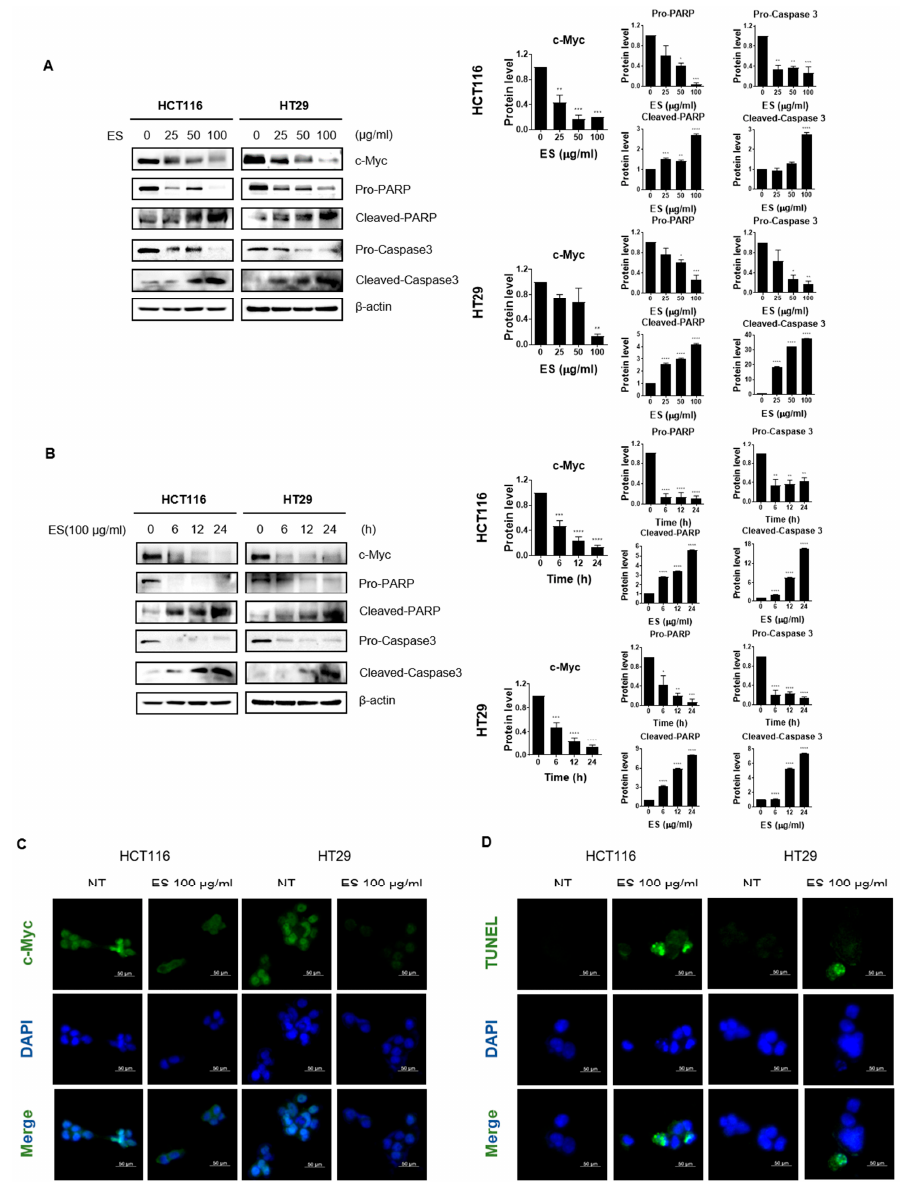
Figure 2. Effect of ES c-Myc and apoptosis-related proteins in colon cancer cells. ( A ) Colon cancer cells were treated with ES at each concentration (0, 25, 50, 100 µ g/mL) for 24 h. The expression levels of c-Myc and apoptosis-related proteins, including pro-PARP, cleaved-PARP, pro-Caspase 3, and cleaved-Caspase 3, were confirmed in the cells by Western blotting. Additionally, the expression level of β -actin, which is used as an internal control, was also checked to confirm whether the equivalent protein was loaded. ( B ) Colon cancer cells were treated with ES 100 µ g/mL at different times (0, 6, 12, and 24 h). The expression levels of c-Myc and apoptosis-related proteins, including pro-PARP, pro-Caspase 3, and β -actin, were detected in the colon cancer cells by Western blotting. ( C ) IF data show that ES treatment decreased the nuclear c-Myc level in the colon cancer cells. ( D ) TUNEL/DAPI staining shows ES induced apoptosis in the colon cancer cells. TUNEL positive cells were stained green, and nuclei were stained blue with DAPI. Taken together, we demonstrated that ES induces apoptosis in colon cancer cells. The magnification of every image is 200 × . Scale bar, 200 µ m. All data are presented as the mean ± SEM. n = 3–4. * p < 0.05, ** p < 0.005 and *** p < 0.001, **** p < 0.0001 with the control